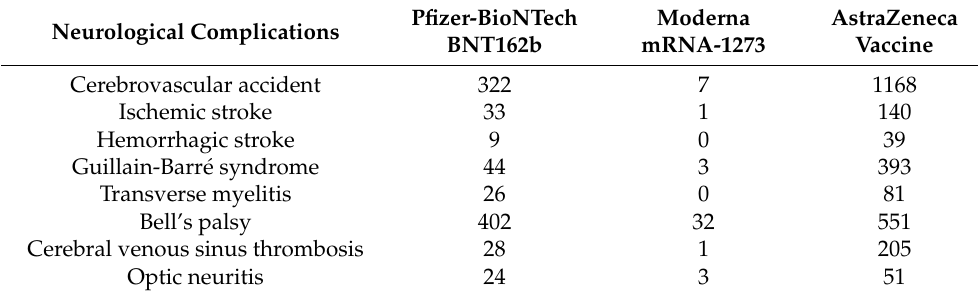
Table 2. COVID Vaccine analysis print UK (as of 27 August 2021).